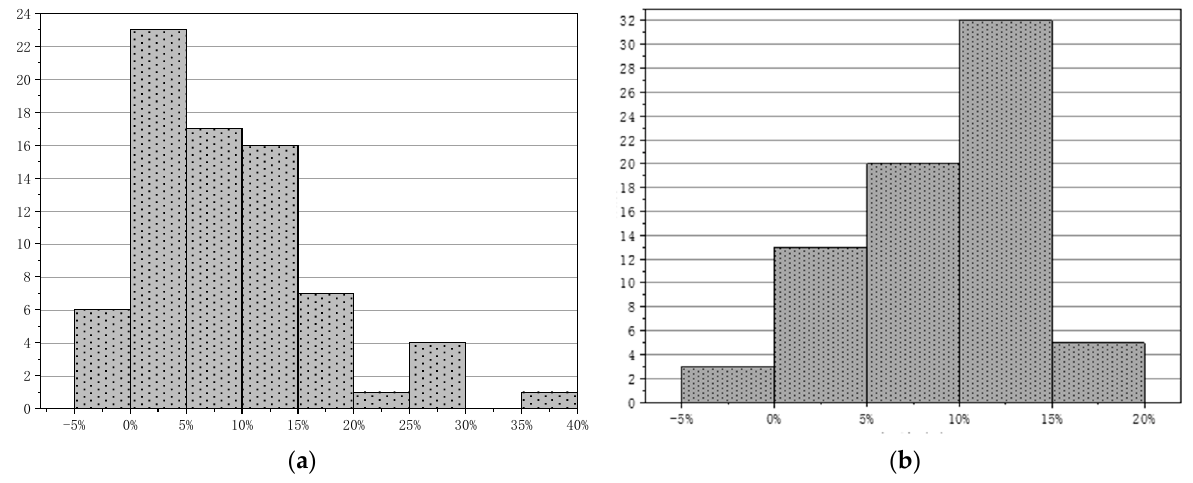
Table 4. Statistical analysis of 𝐾 (cid:3036) of bridge A and bridge B.